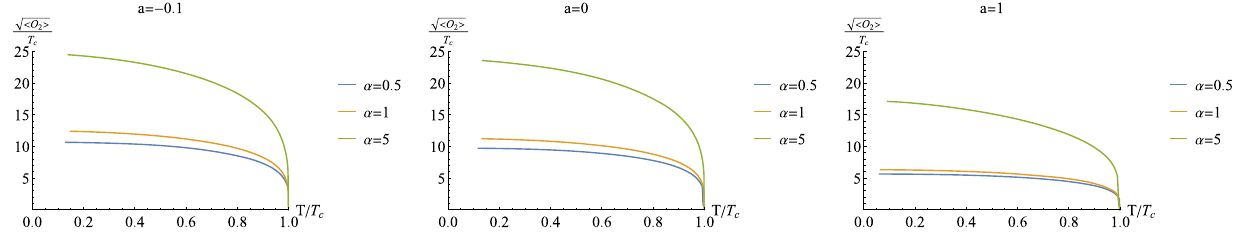
Fig. 3 The condensation < O 2 > as a function of temperature for given a (from left to right a = − 0 . 1, a = 0 and a = 1) and various values of α . We have set q = 2 and n = 1. Here we have abbreviated the two dimensionless quantities { T /μ,α/μ } to { T ,α }